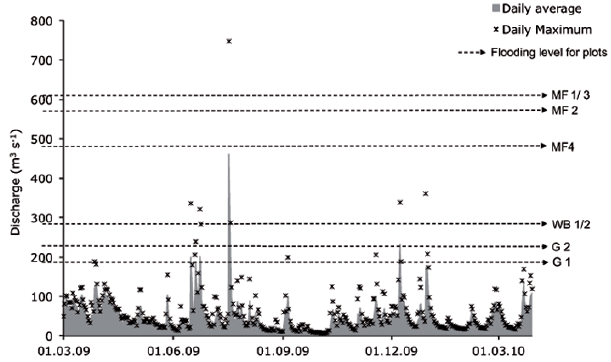
Fig. 2. Daily average and maximum discharge of the Thur River at the test site, and minimum discharge required for inundation of the different plots (Pasquale et al.,